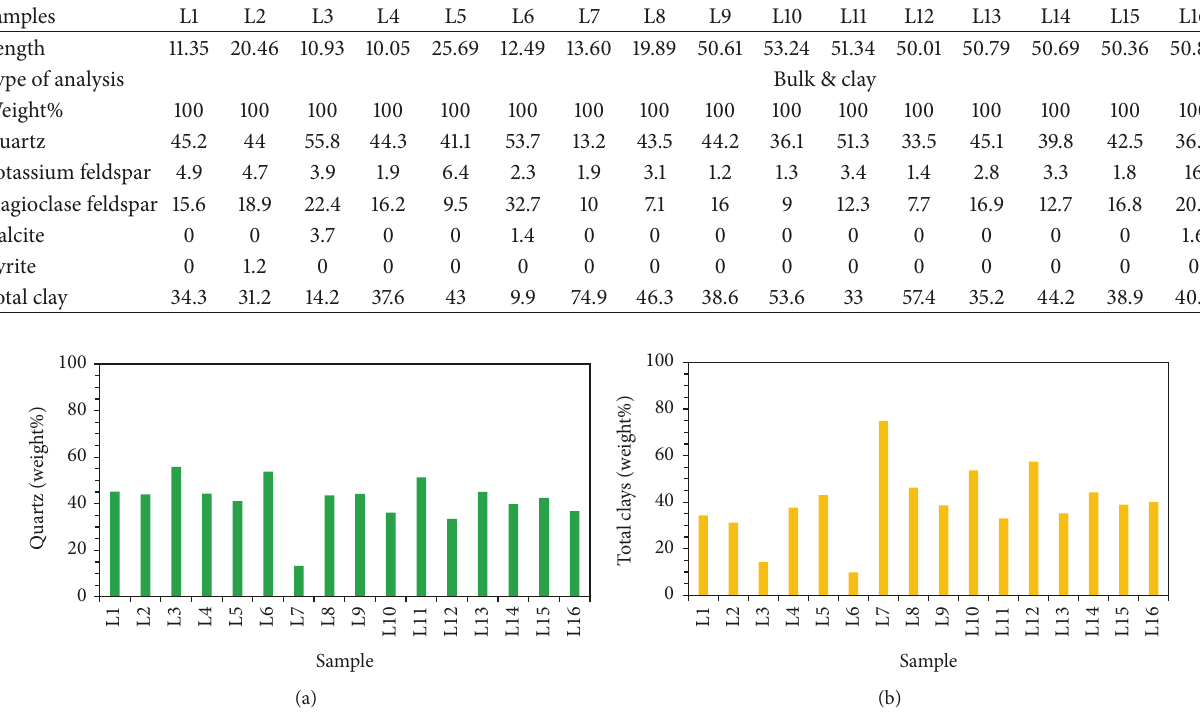
Figure 1: (a) Quartz on the left, (b) total clays on the right of various volcanic samples from various depths.